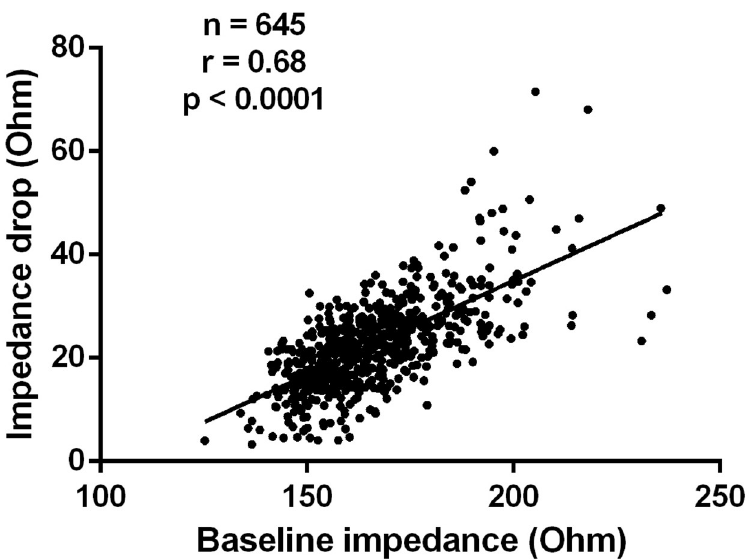
Fig 3. Scatter plot with the line of best fit demonstrating the correlations between starting local impedance and local impedance drop. Abbreviations: n = number of applications, r = correlation coefficient.